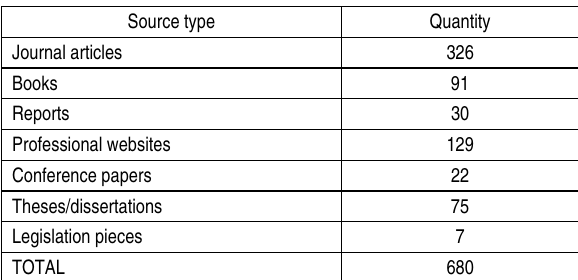
Table 1. The sources which were scouted